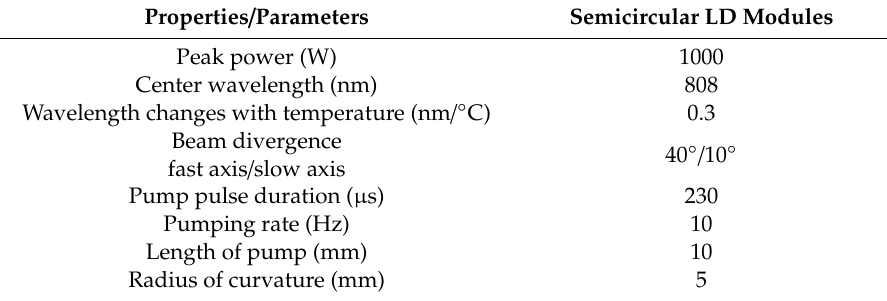
Table 2. The properties and parameters of semicircular LD arrays modules used in the simulation.